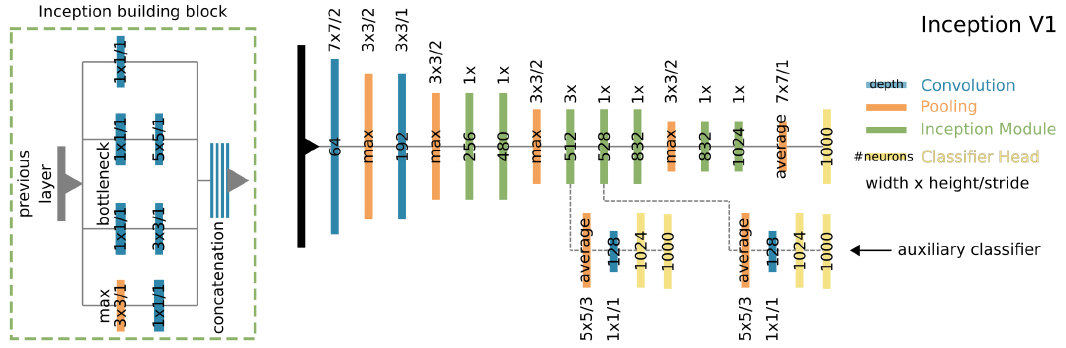
Figure 6. Conceptual overview of the Inception module and Inception V1 architecture [40]: ( Left ) the Inception module shows the 1 × 1 convolutional bottleneck layers, which reduce depth before the 3 × 3 and 5 × 5 convolutional operations; and ( Right ) the overall architecture of Inception V1 that consists of stacked Inception modules with increasing output depth and sparse max pool operations in